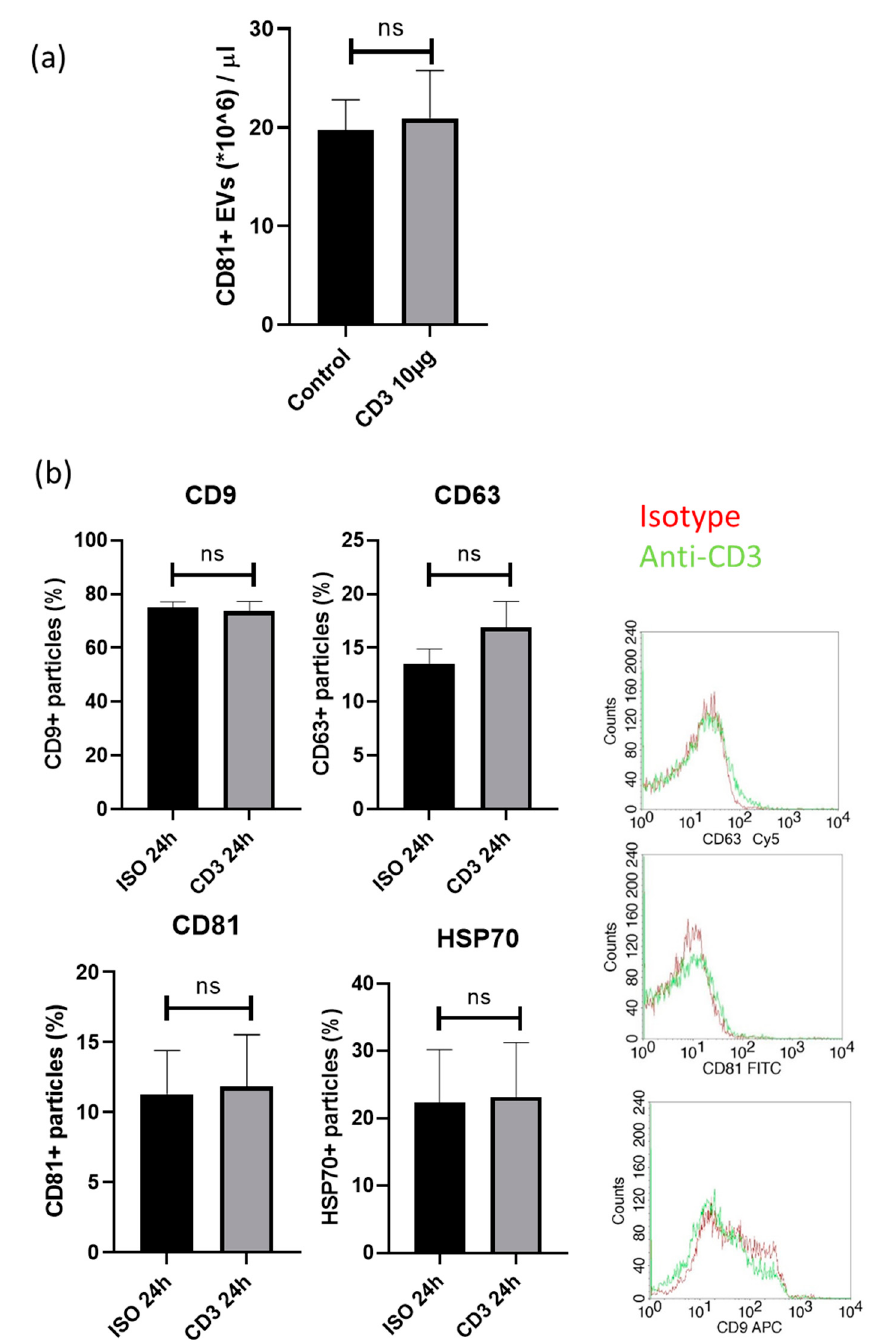
Figure 5. Exosome markers were assessed by ( a ) exoELISA and ( b ) FACS. The expression of the exosome marker ( a ) CD81 was not different (20.94 ± 4.84 × 10 6 exosomes/µL versus 39.36 ± 3.14 × 10 6 exosomes/µL; p = n.s.) compared to isotype control. The expression ( b ) of exosomes positive for CD9 (74 ± 4% versus 75 ± 2%; p = n.s), HSP70 (22 ± 8% versus 23 ± 8%; p = n.s) or CD81 (11 ± 3% versus 12 ± 4%; p = n.s.) and CD63 + exosomes (14 ± 1% versus 17 ± 2; p = n.s.) was unchanged upon anti-CD3 antibody treatment compared to isotype